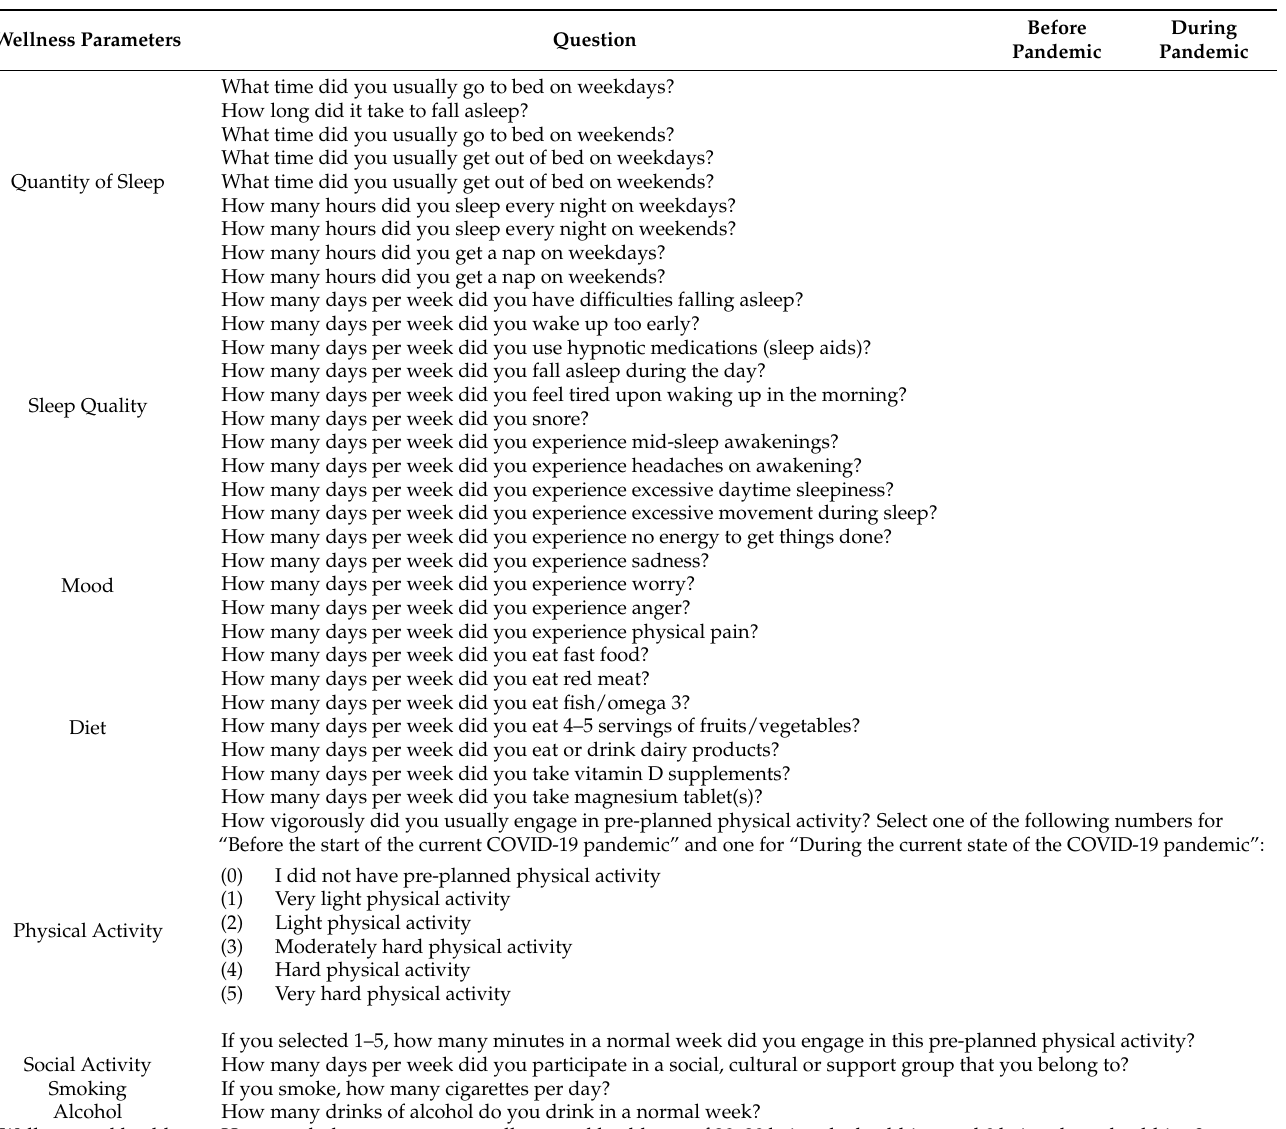
Table 1. Lifestyle questionnaire and the parameters assessed by each